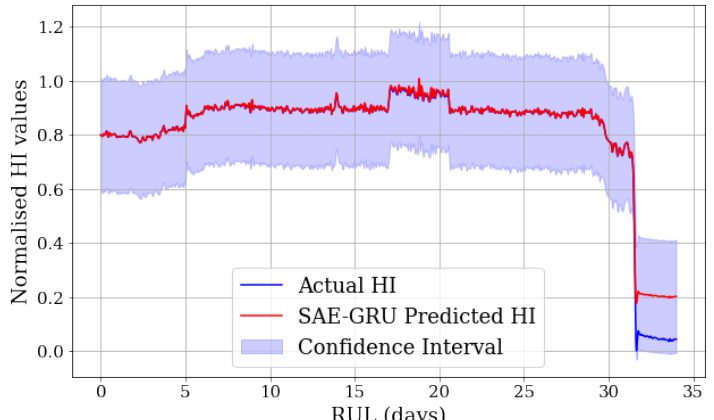
trend is represented in the red lines.